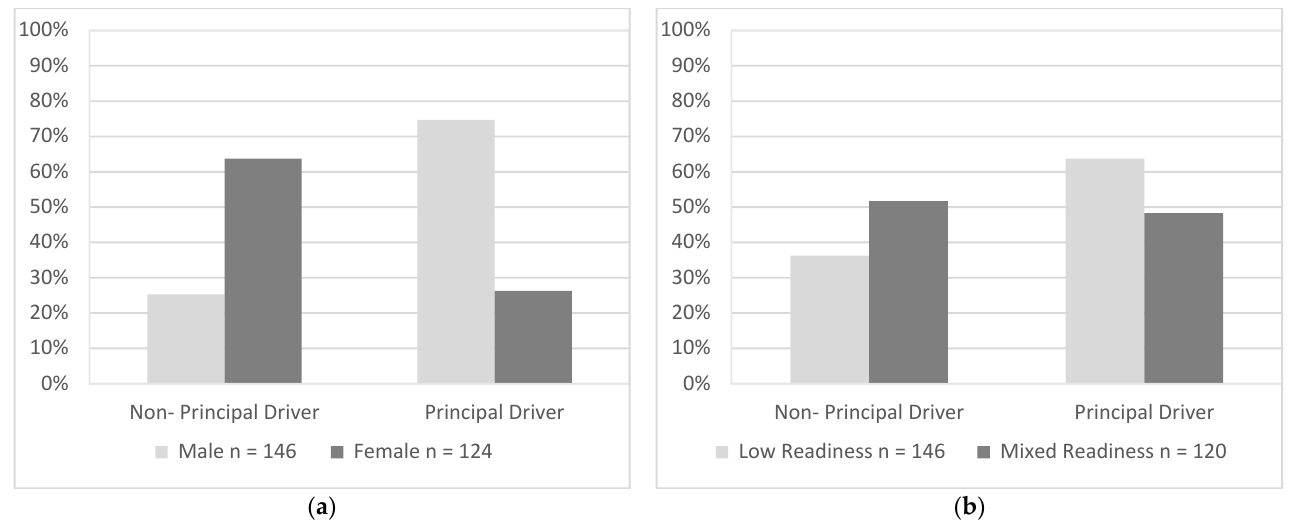
Figure 2. Driving Roles as endorsed by participants in each group that use driving as their primary mode of transport and had other drivers in their household. Percentages represented proportions of participants in each group who responded “yes” or “no” to the following item, “Do you do the majority of driving in your household.” ( a ) Gender, ( b ) Readiness.